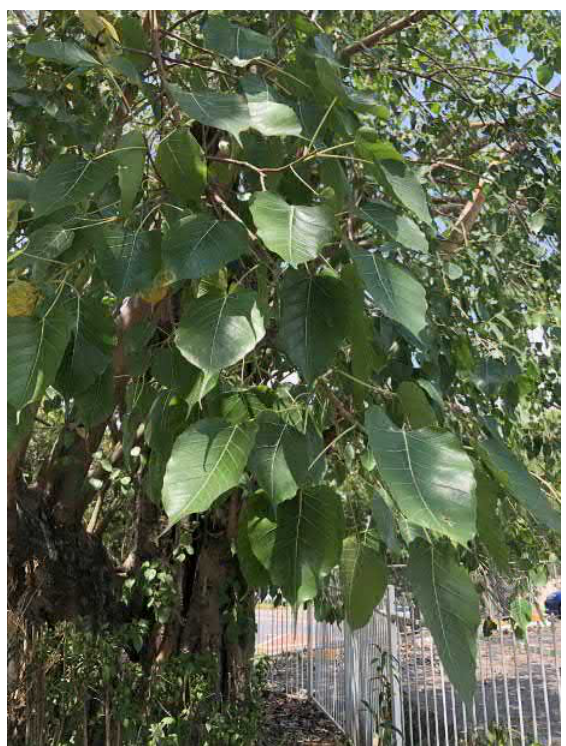
Figure 3: Bodhi tree, NT Chinese Temple and Museum, Darwin. (Photo: Anna